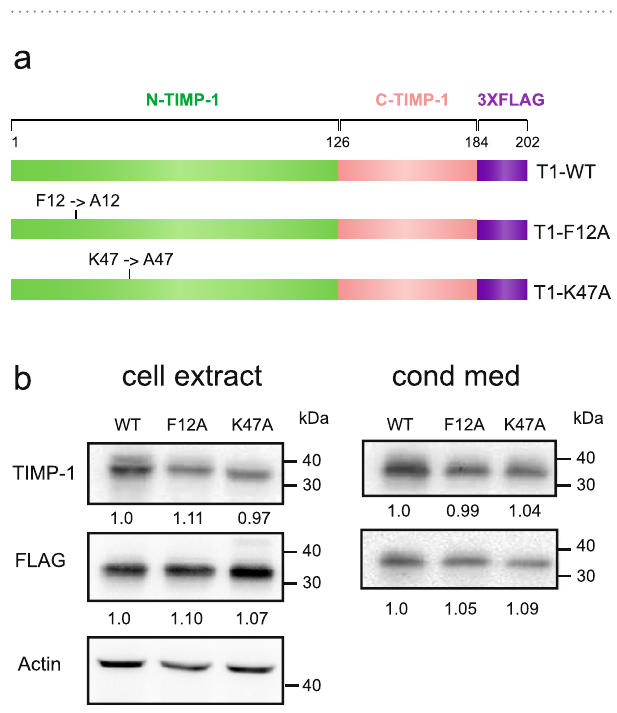
Figure 3. Principal component analysis derived from molecular dynamics simulation of TIMP-1. For each PC, the contribution of each residue to the overall atomic displacement was determined. The green arrows point out residues F12 and K47.